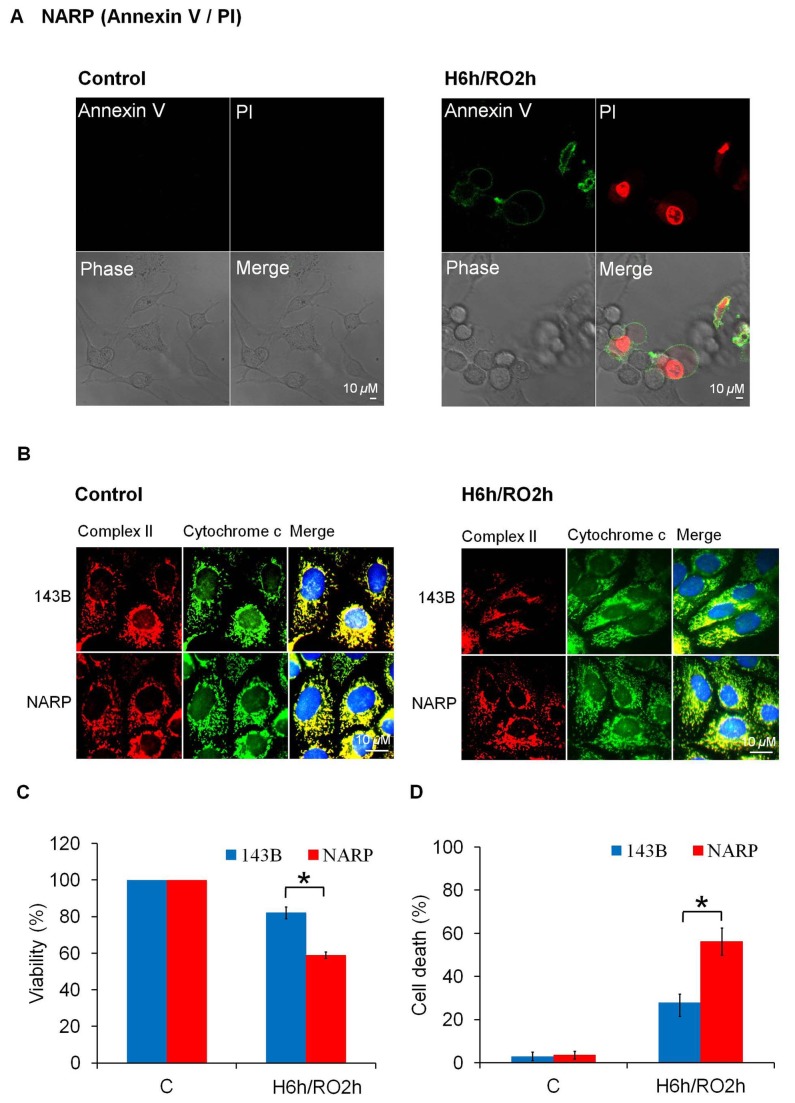
Hypoxia/reoxygenation (H/RO) induced apoptotic death in NARP cybrids and 143B cells.(A) H/RO (H: 6h, RO: 2h) induced apoptosis in NARP cybrids as measured by Annexin V-propidium iodide (PI) staining. (B) H/RO induced cytochrome c release from mitochondria in NARP cybrids and 143B cells as measured by immunocytochemical analysis. Red color: mitochondrial complex II; Green color: cytochrome c. Note that cytochdrome c and complex II co-localized well before H/RO (yellow color). After H/RO, green fluorescent signal was released from mitochondria in NARP cybrids and 143B cells, which suggested that cytochdrome c was released from mitochondria. (C) MTT assay. After H/RO, cell death was noted in NARP cybrids and 143B cells (death ratio: NARP > 143B). (D) Trypan blue exclusion test of cell viability. After H/RO, cell death was noted in NARP cybrids and 143B cells (death ratio: NARP > 143B). *P<0.05 as compared with control; n=3.